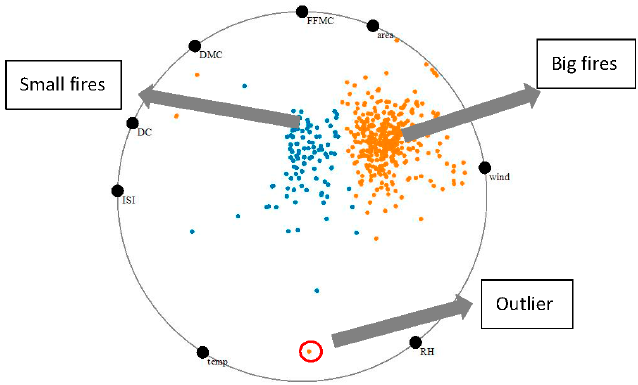
Figure 15. RadViz Deluxe visualization of the forest fire data set.